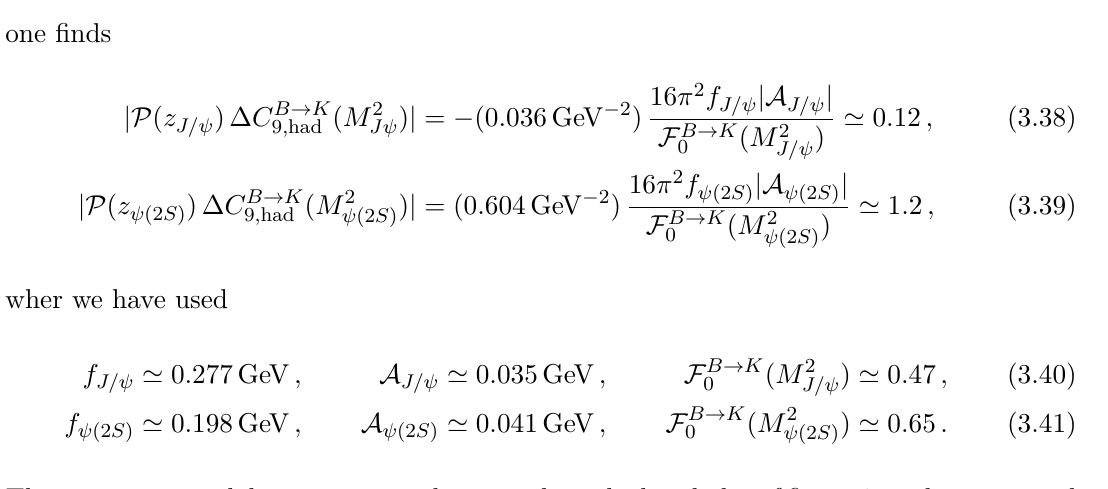
Figure 3 . Allowed values for the magnitudes of ∆ C B → K ( q 2 ) . Same color coding as in figure 2. The diamonds in the right-hand plot show the P ( z )∆ C B → K 9 , had experimental data points on the charmonium poles (central values only). The resulting constraints on | ∆ C B → K ( q 2 ) | are shown as the shaded region in the left plot (including only one theory data 9 , had point). See text for